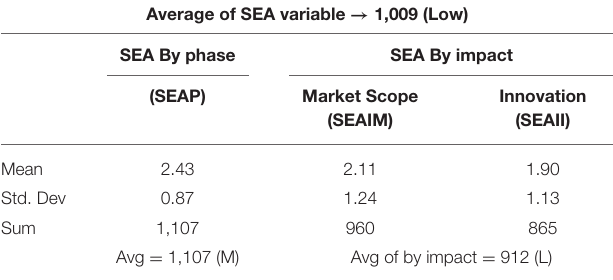
TABLE 8 | Descriptive analysis of SEA